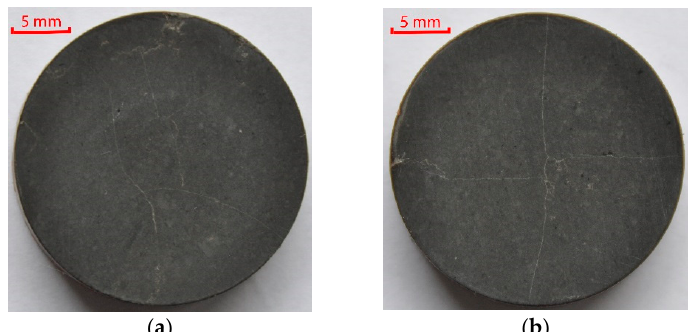
Figure 8. Optical microscope with 3D software.